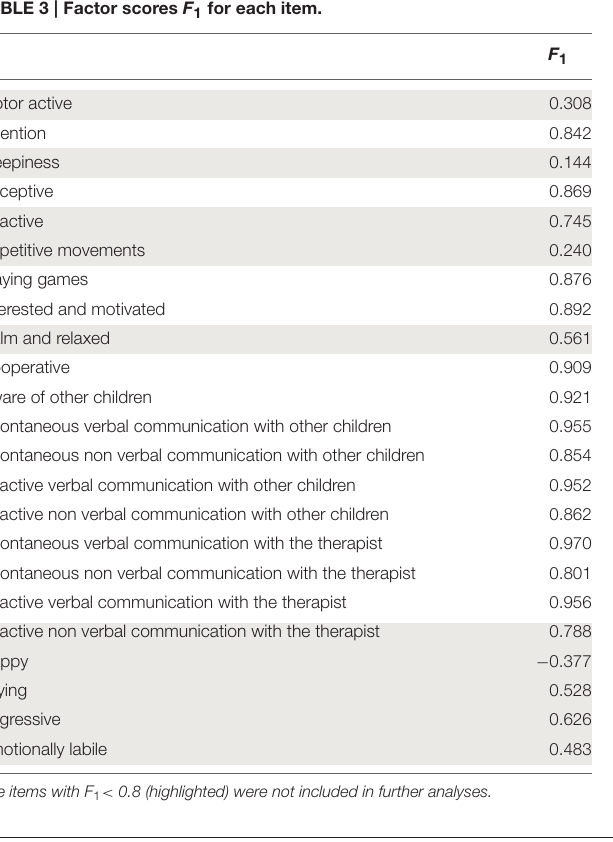
Frontiers in Neuroscience |